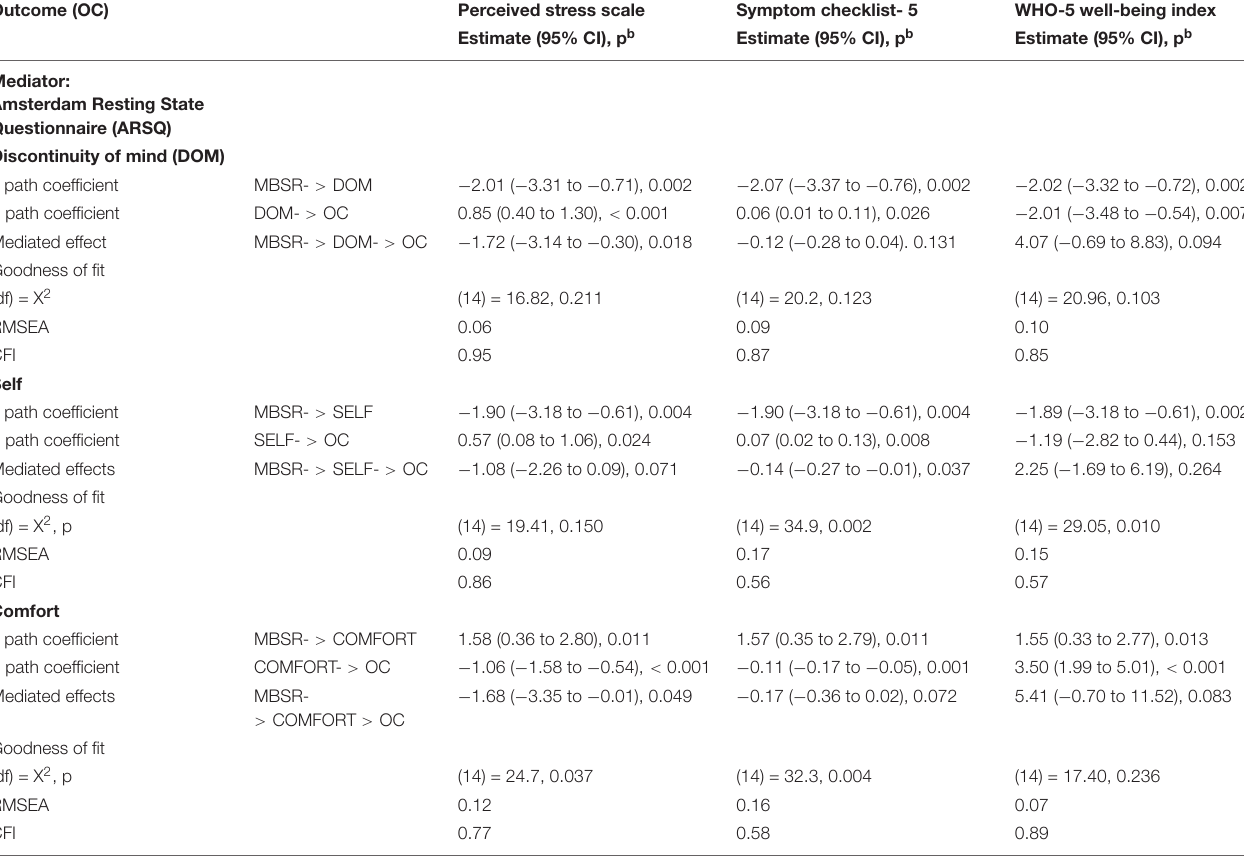
TABLE 4 | Results of single mediation models a in an RCT evaluating the effects of a mindfulness program including MBSR among students at VIA’s undergraduate program for teacher education ( n = 67), Denmark. Outcome